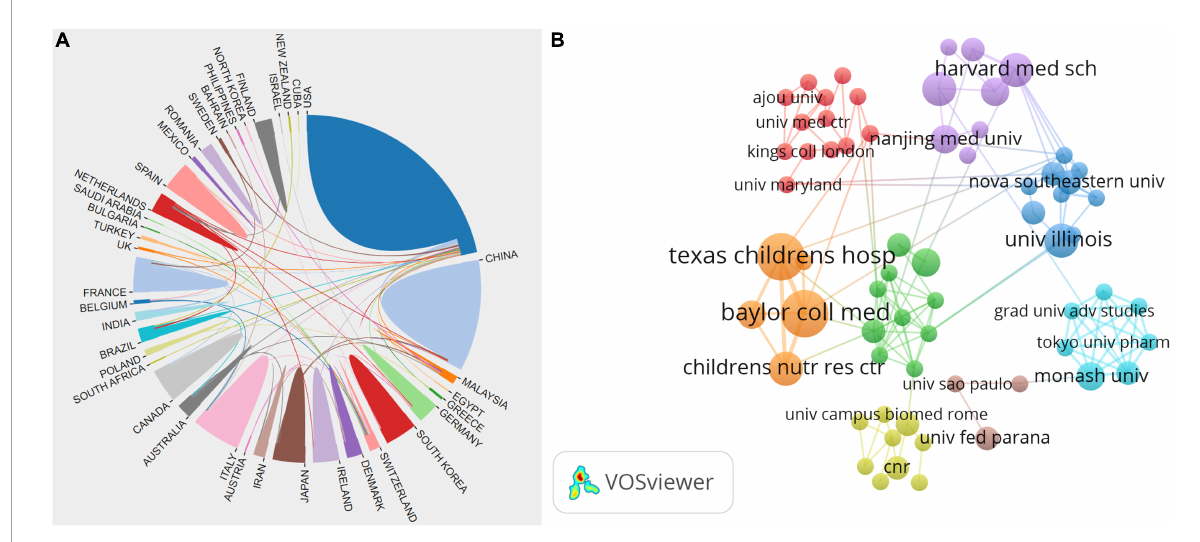
FIGURE3 Visualization map of the scientific collaboration network analysis of gut microbiota research in the pain field from 2002 to 2021. Collaboration among countries/regions (A) , institutions (B) . The size of the concentric circle represented the number of articles published by each institution and the thickness of the connecting lines indicated the degree of cooperation between institutions. The brighter the color of the concentric circle is, the more productive the institution has been on the topic of the links between the gut microbiota and pain in recent